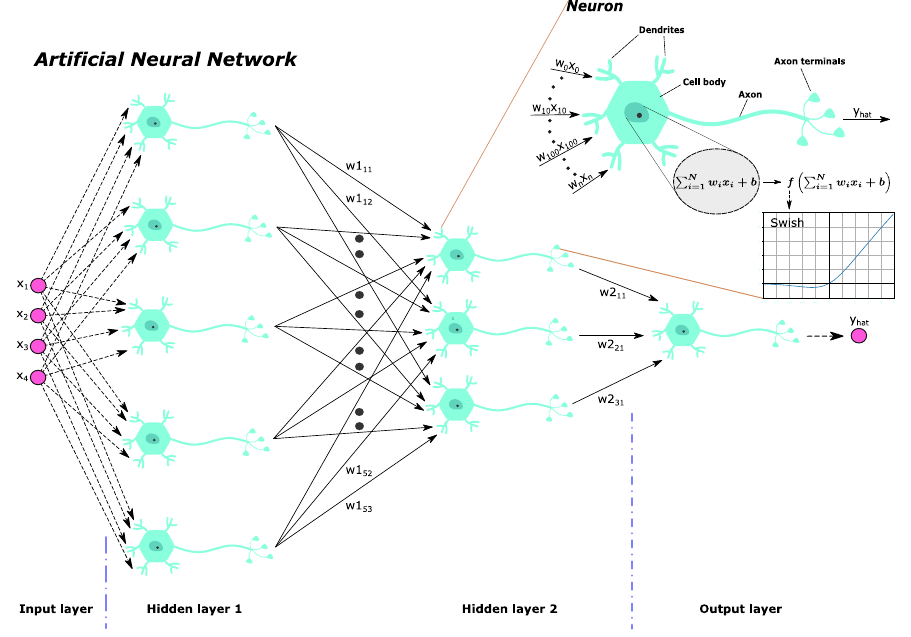
Figure 5. ANN depicted as a